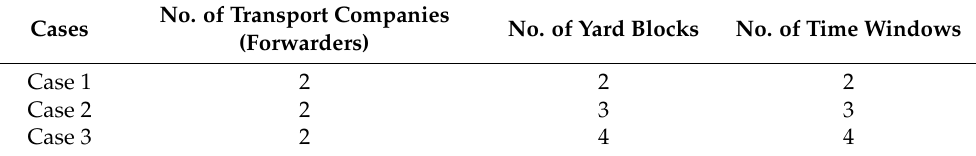
Table 1. Cases for the change in the number of yard blocks and time windows.